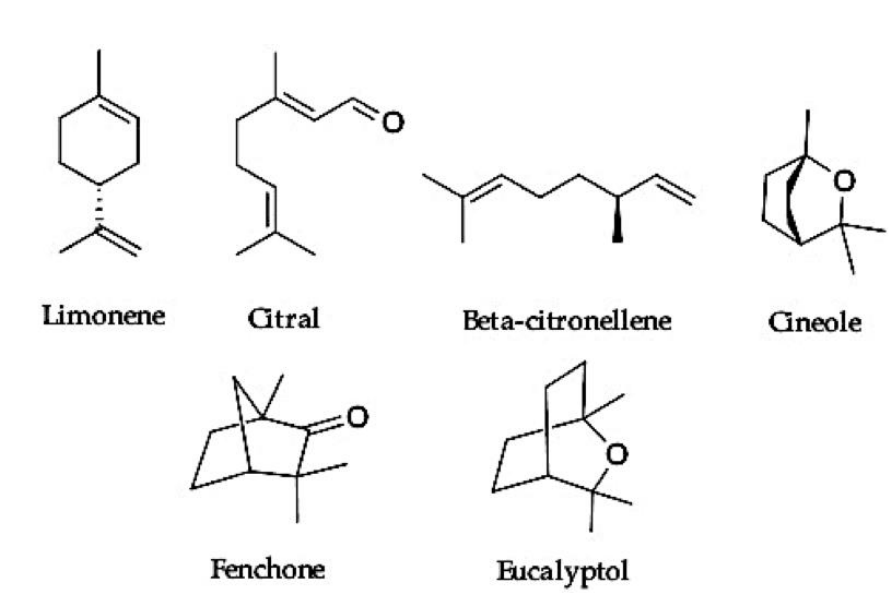
Figure 2. Representatives of monoterpenes and monoterpenoids applied as skin permeation enhancers.